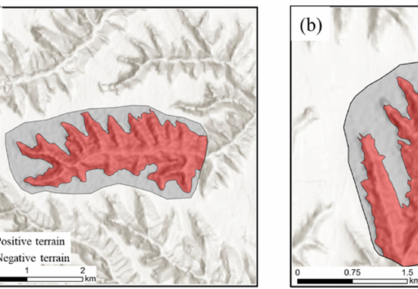
Figure 8. The result of extracting Negative terrain by edge detection method. ( a – d ) represent 4 sam- ple areas.